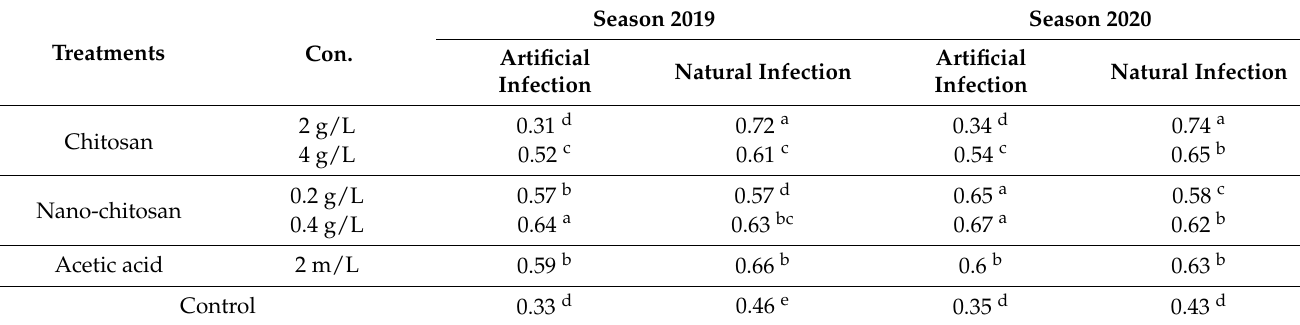
Table 6. Effect of chitosan and its nanoform on titratable acidity of Anna apples after 45 days of cold storage at 4 ± 1 ◦ C during seasons 2019 and